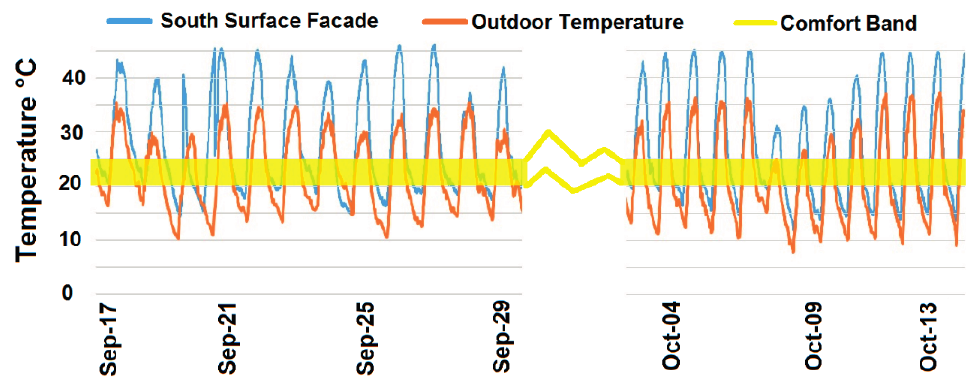
Figure 19. Temperatures in the inner South surface of the roof, mid-September to mid-October.